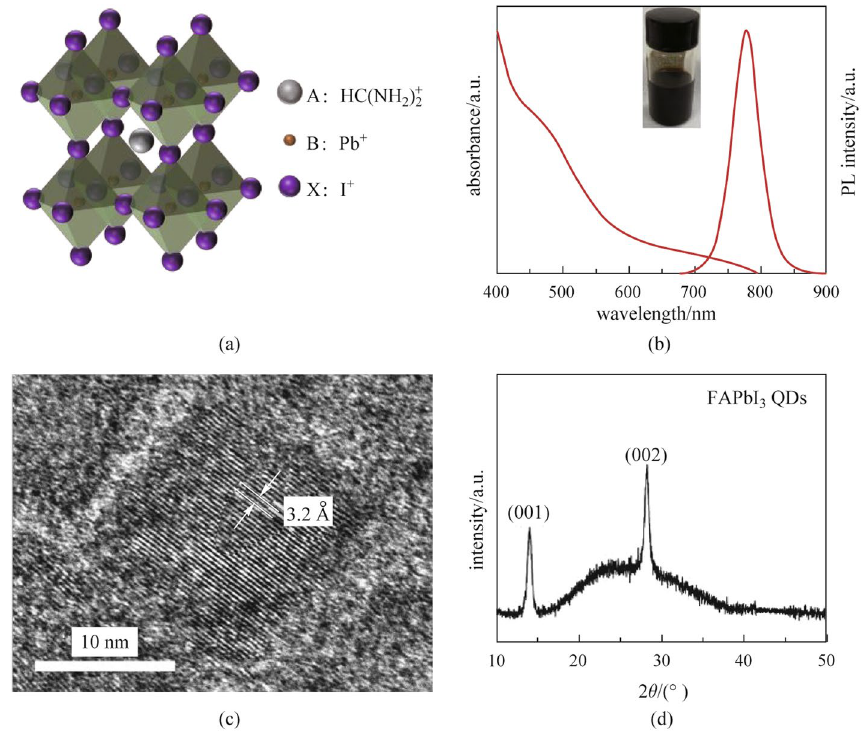
Fig. 1 Fundamental properties of FAPbI 3 PQDs. a Schematic diagram of the cubic phase of the FAPbI 3 perovskite crystal structure. b UV–vis- ible absorption and PL spectra of FAPbI 3 PQDs. Inset shows the photograph of the PQD solution. c TEM image and d XRD pattern of FAPbI 3